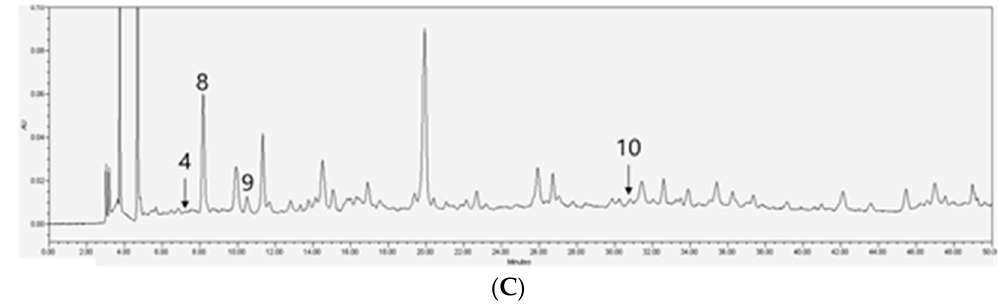
Figure 2. HPLC chromatograms of standard mixture ( A ), H. diffusa extract ( B ) and H. corymbosa extract ( C ).